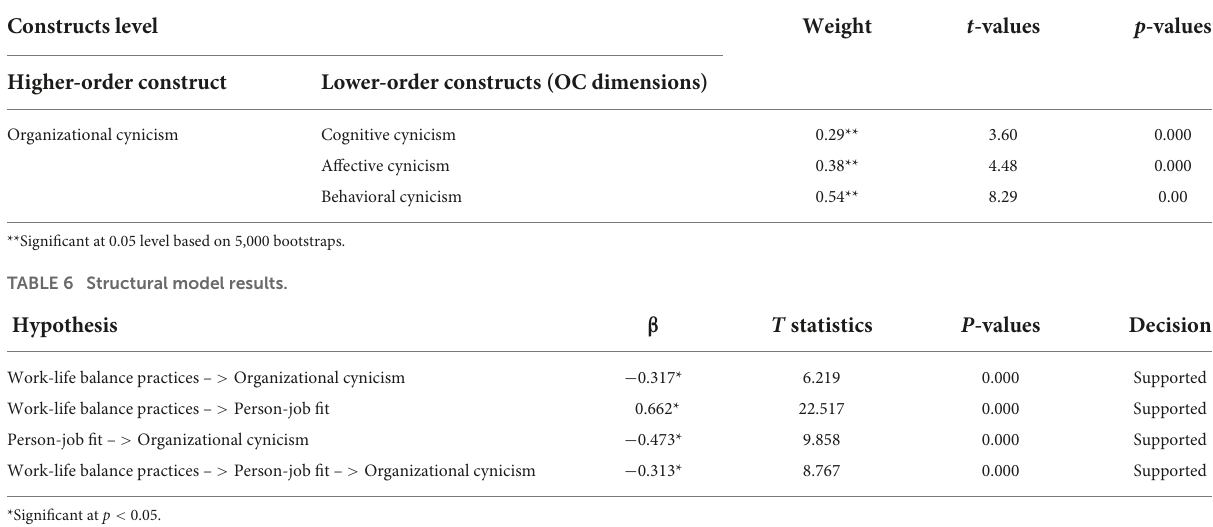
TABLE 5 Outer weight of the dimensions of organizational cynicism (OC) on OC.